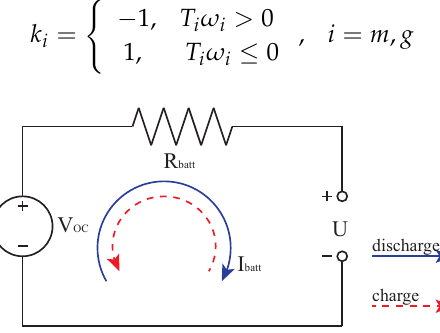
Figure 4. Zero order equivalent